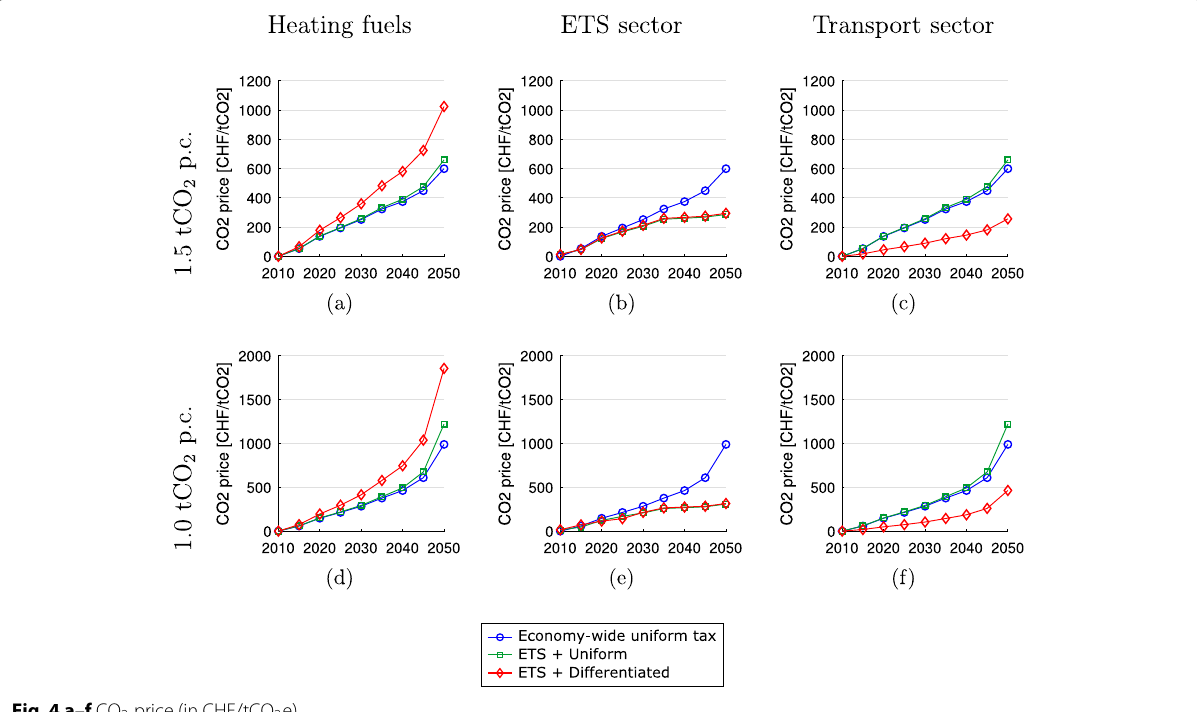
Fig. 4 a – f CO 2 price (in CHF/tCO 2 e)